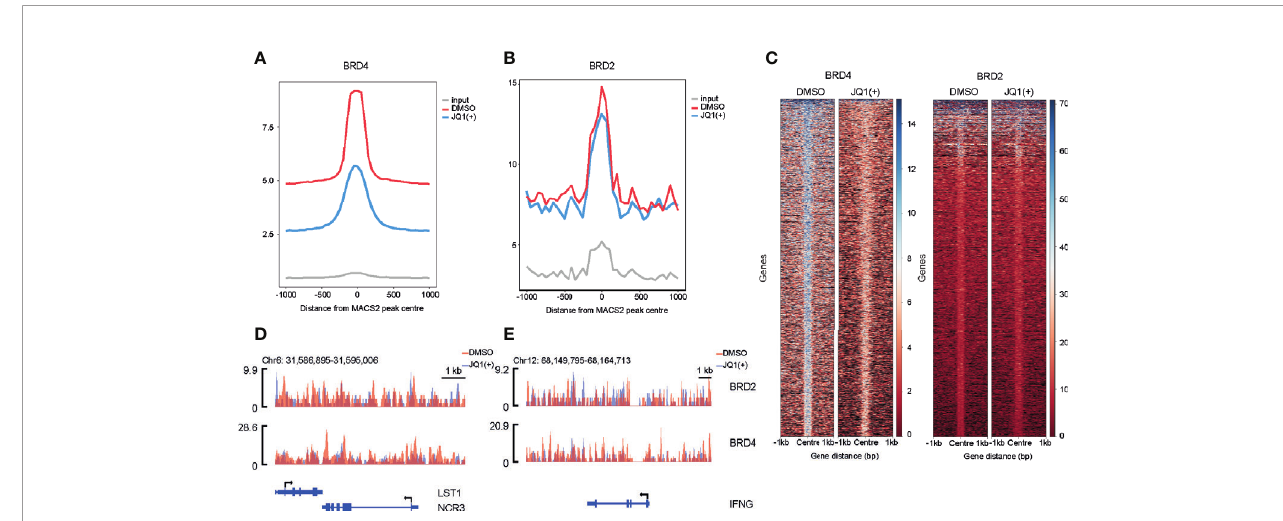
FIGURE 8 | Genome-wide BRD2 and BRD4 occupancy following stimulation of NK cells with IL-15 (10 ng/ml) and 24 h of JQ1(+) treatment of NK cells. (A) Coverage plot showing average read counts centered around the transcriptional start site (TSS) from BRD4 ChIP-seq following DMSO or JQ1(+) treatment of NK cells. (B) Coverage plot showing average read counts centered around the TSS from BRD2 ChIP-seq following DMSO or JQ1(+) treatment of NK cells. (C) Heatmap of BRD4 and BRD2 following treatment of NK cells with DMSO or JQ1(+) covering 1 kb upstream and downstream of the center of called peaks. (D) Representative ChIP-seq coverage pro fi les for BRD2 and BRD4 across the NCR3 locus. (E) Representative ChIP-seq coverage pro fi les for BRD2 and BRD4 across the IFNG